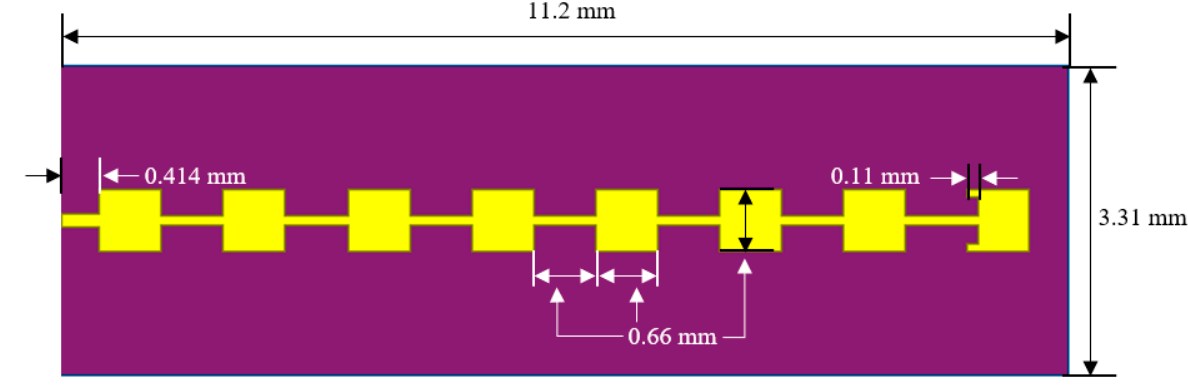
Figure 3. One-by-eight array with inset feed on the eighth element.